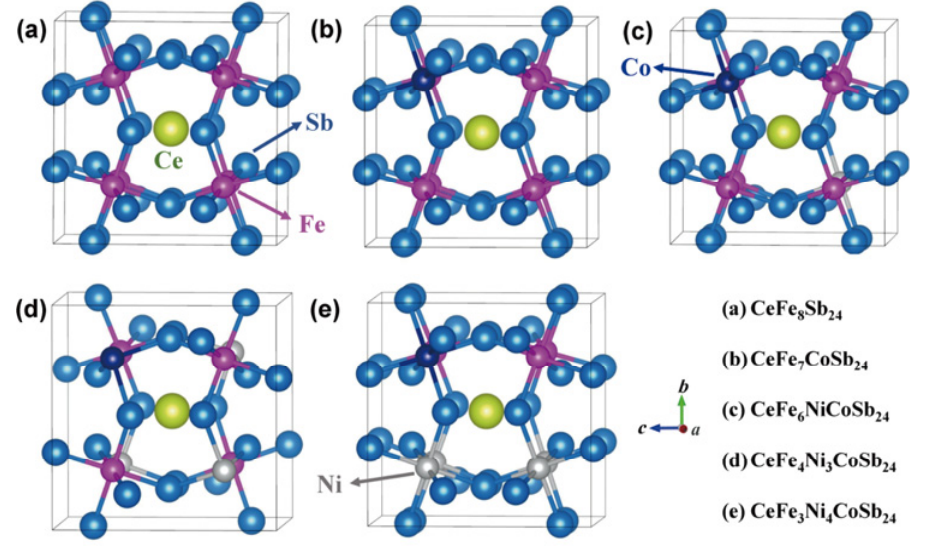
Fig. 1 Stable crystal structures (with the lowest self-consistent energy) for CeFe 8 Sb 24 and CeFe 7 − x Ni x CoSb 24 ( x = 0, 1, 3, and